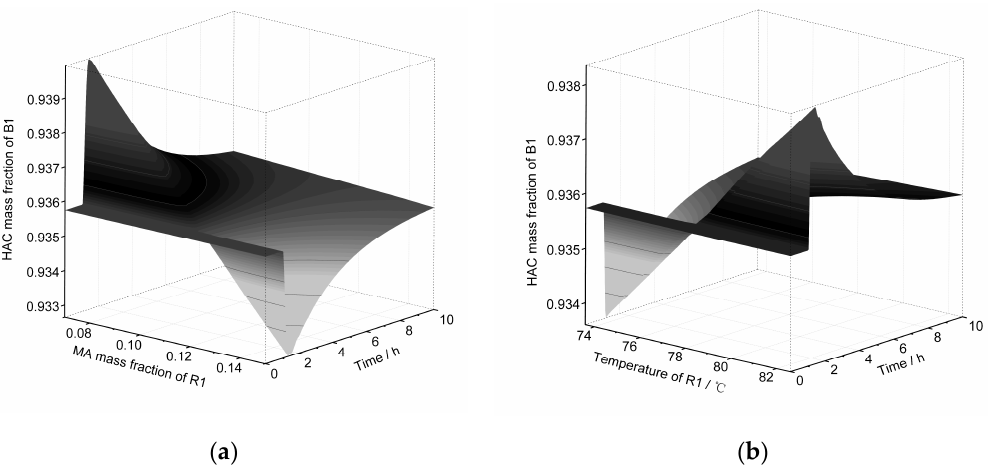
Figure 7. Sensitivity analysis of the added temperature and component controllers. ( a ) Dynamic sensitivity analysis of the MA mass fraction in the R1 to the HAc mass fraction at the bottom of the column. ( b ) Dynamic sensitivity of the temperature in the R1 to the HAc mass fraction at the bottom of the column.